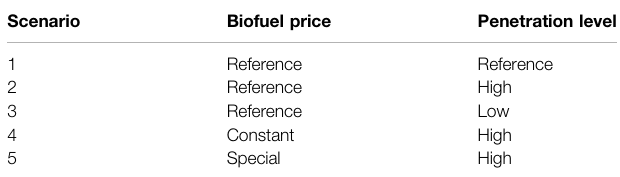
TABLE 2 | Future SAF scenarios.